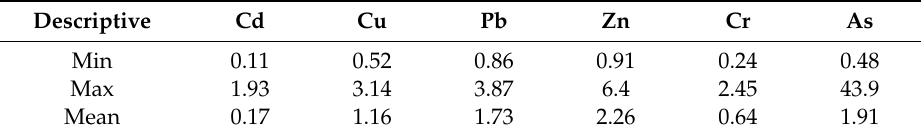
Table 13. Results of contamination index ( CL i